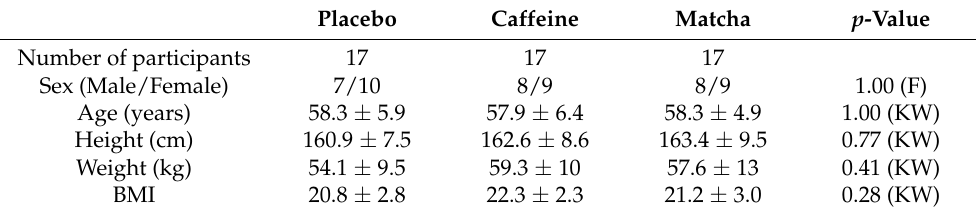
Table 3. The participants’ clinical characteristics. Placebo p